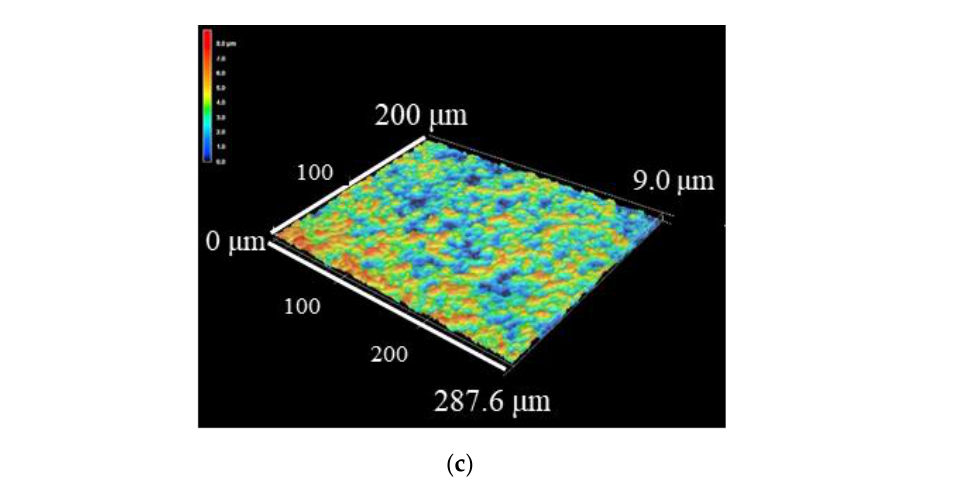
Figure 7. 3D profiles of the surface of Si 3 N 4 : ( a ) Non-LP specimen; ( b ) LPC-1; ( c ) LPwC-1.